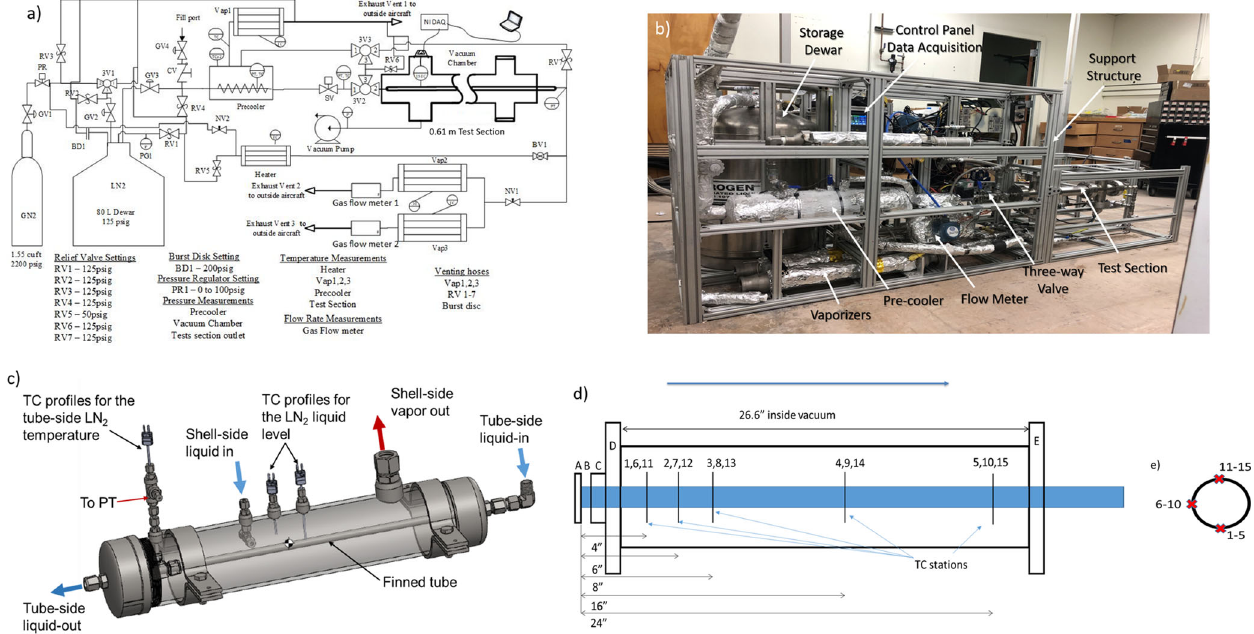
Fig. 5 Experimental Design. a Flight system piping and instrumentation diagram, b actual fl ight line chilldown rig, c pre-cooler, d test section, vacuum chamber, and thermocouple locations, A: Inlet, B: 3.81 cm (1.5 in) long tube section, C: ultra-torr fi tting, D: left fl ange, E: right fl ange and e thermocouple locations at each